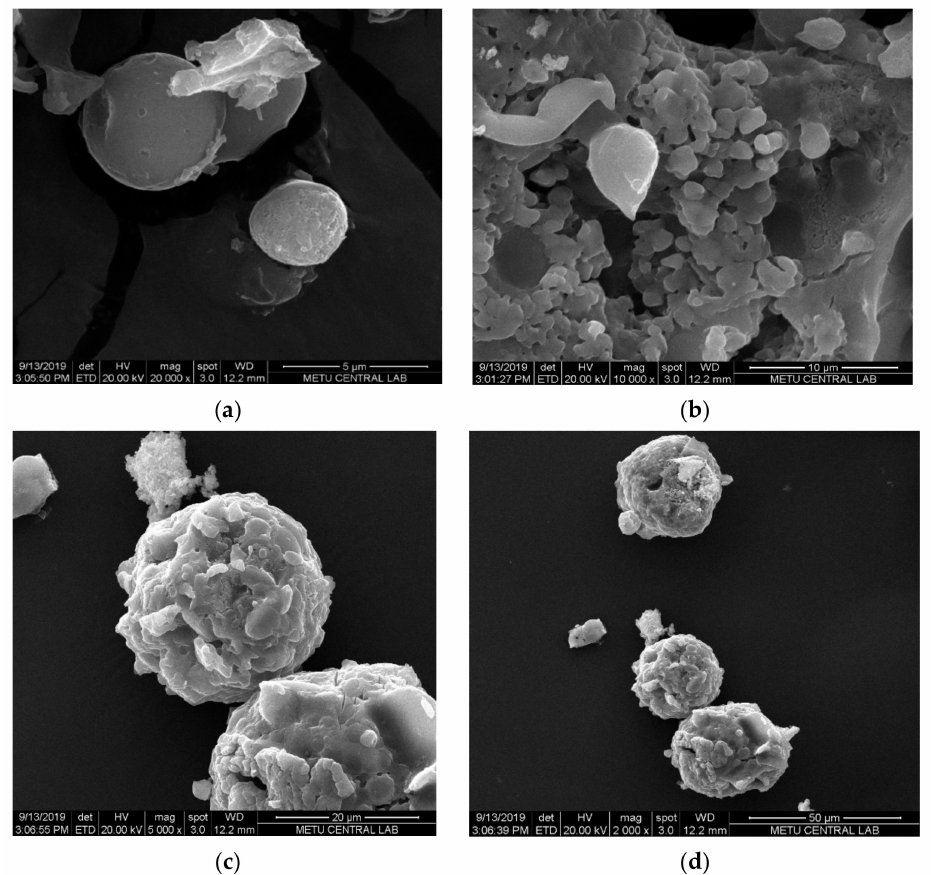
Figure 3. SEM micrographs of SFCP microparticles at ( a ) 5 µ m, ( b ) 10 µ m ( c ), 20 µ m, and ( d ) 50 µ m scales.